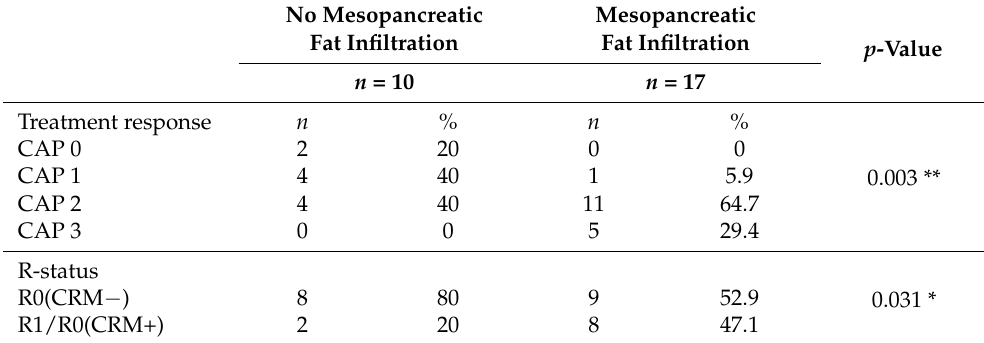
Table 2. Analysis of patients stratified according to positive and negative mesopancreatic infiltration, n = 27. There was a heterogenous distribution of clinico-pathological variables. Statistical significance was calculated by chi-squared test. ** indicates a p -value ≤ 0.01; * indicates a p -value ≤ 0.05. No Mesopancreatic Fat